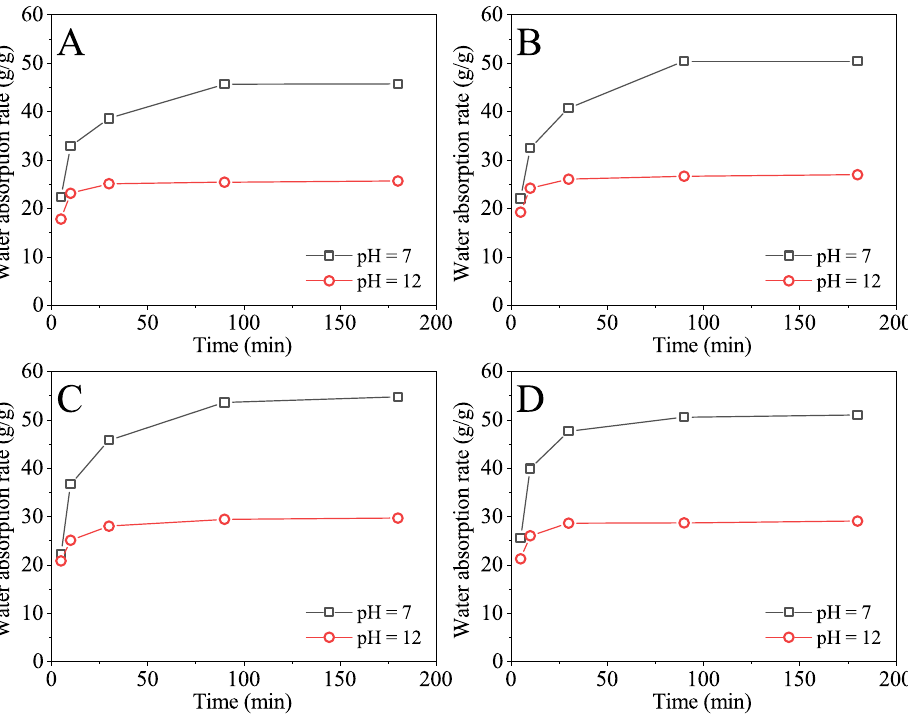
Figure 1. The absorption rates of SAPs prepared with different monomer ratios tested at 90 ◦ C in water (pH = 7), and in NaOH solution (pH = 12) varied with time; the ratios of DMAA to DMDAAC are ( A ) 10:9, ( B ) 10:12, ( C ) 10:15, and ( D ) 10:18. Table 3. The saturated absorption rates of SAPs prepared with different monomer ratios tested at 90 ◦ C in water (pH = 7), and in NaOH solution (pH = 12), and the pH-sensitive index. Monomer